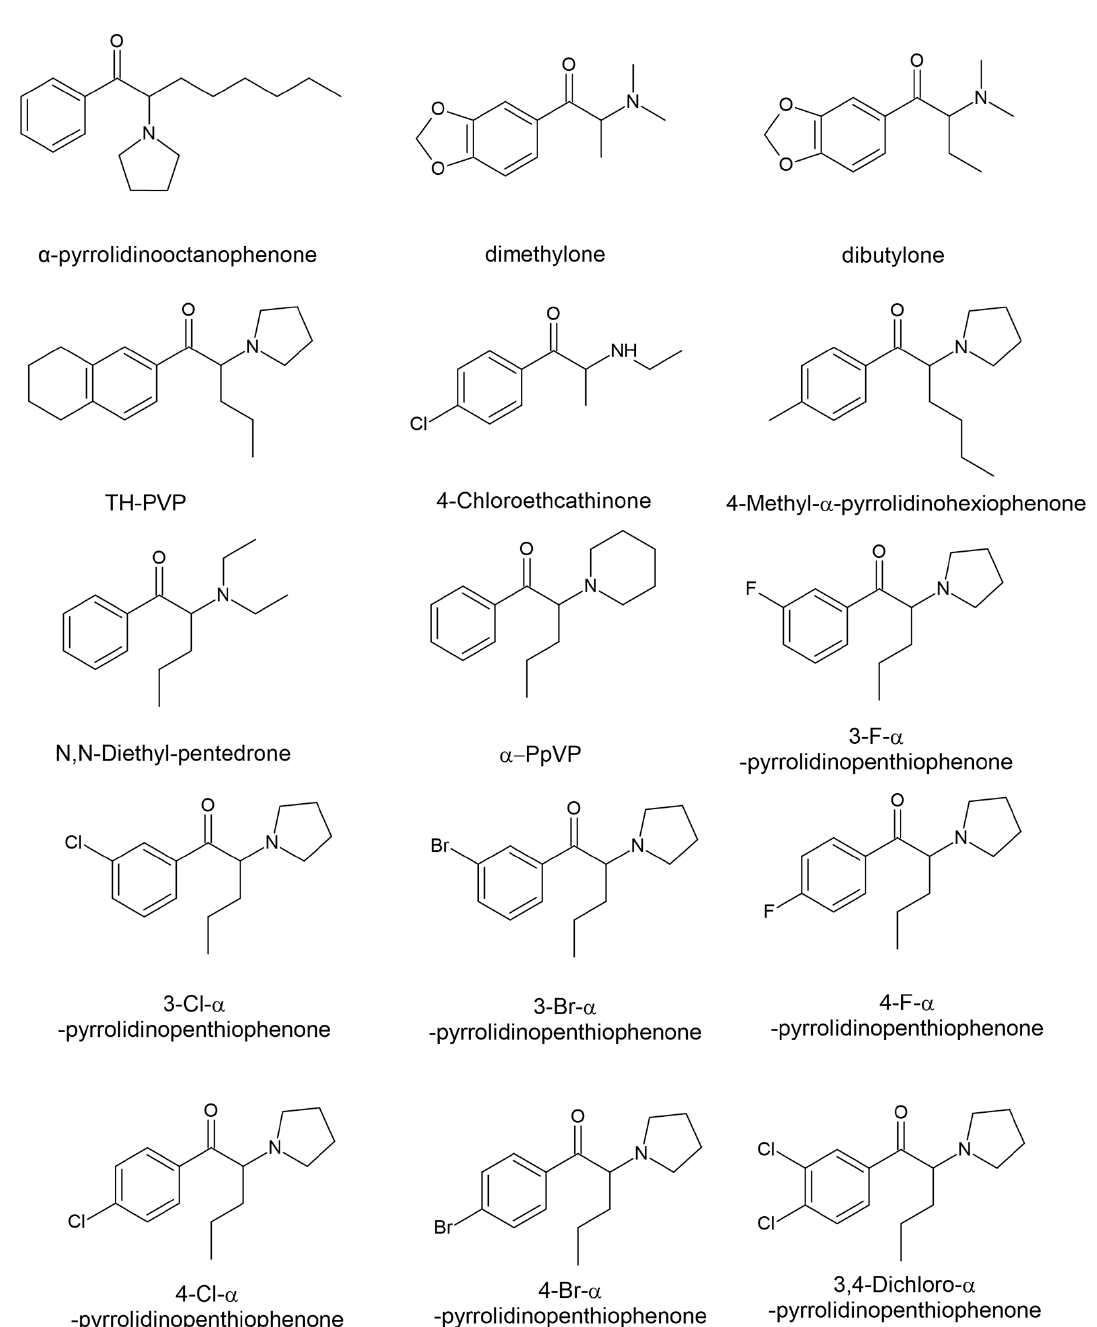
Figure 1. SCs used as drugs of abuse with common names and chemical structures.